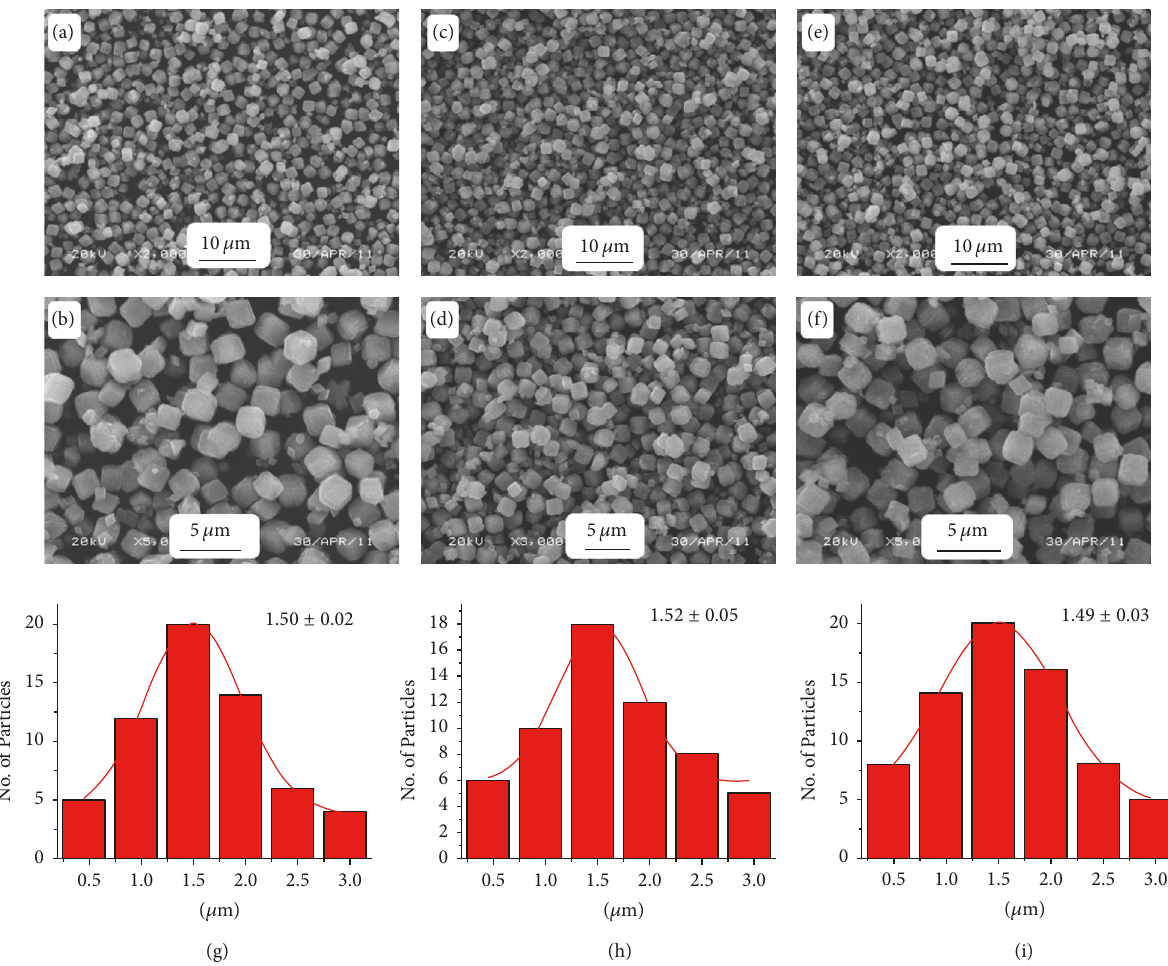
Figure 1: SEM analysis of the as-synthesized catalysts calcined at (a-b) 300 ∘ C; (c-d) 400 ∘ C; (e-f) 500 ∘ C. (a-b) Overview image for as- synthesized 1% ZrO –MnCO 3 ; (c-d) overview image of 1% ZrO x distribution of 1% ZrO –MnCO 3 ; (h) particle size distribution of 1% ZrO x